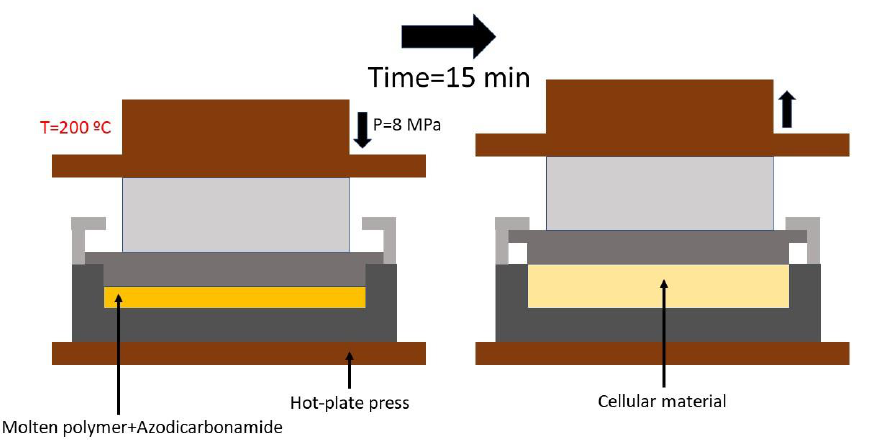
Figure 1. Improved compression molding method schema with the used parameters in these experiments.